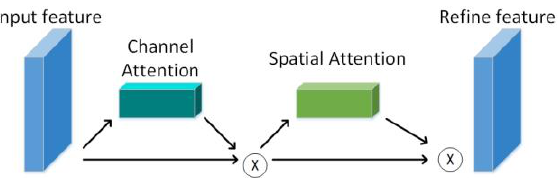
Figure 2. The serial structure of channel attention and spatial attention.